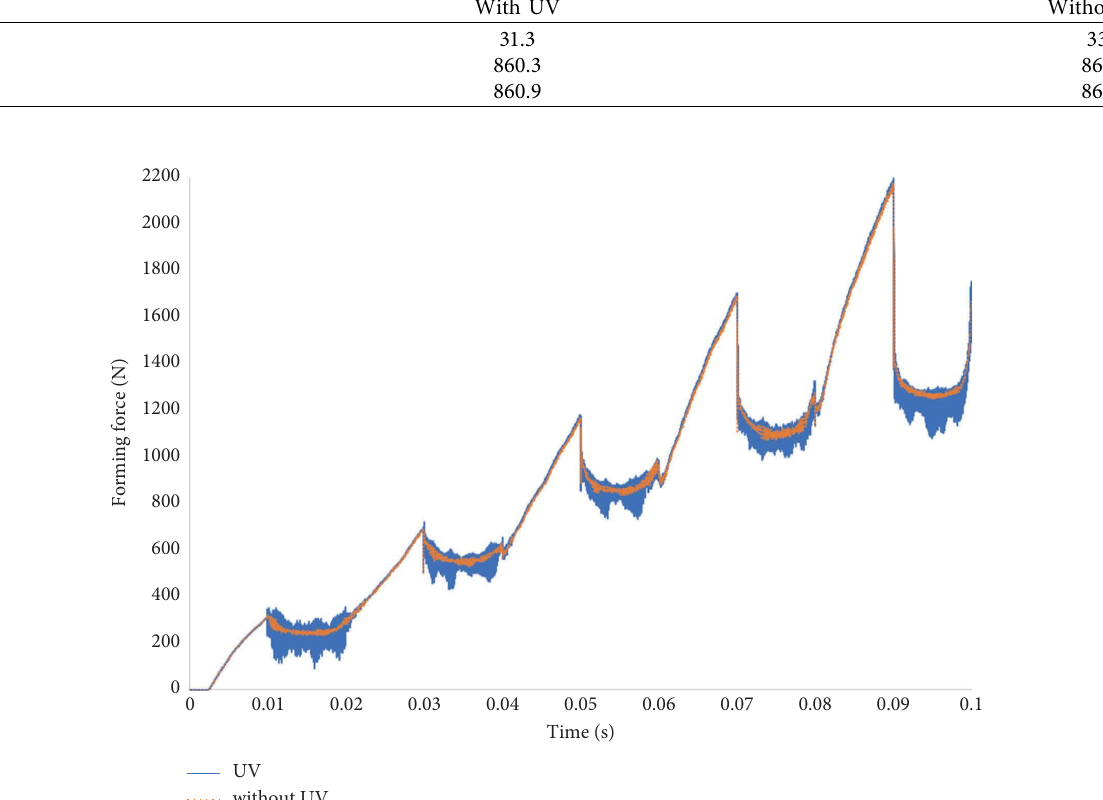
Figure 7: Axial force of straight groove